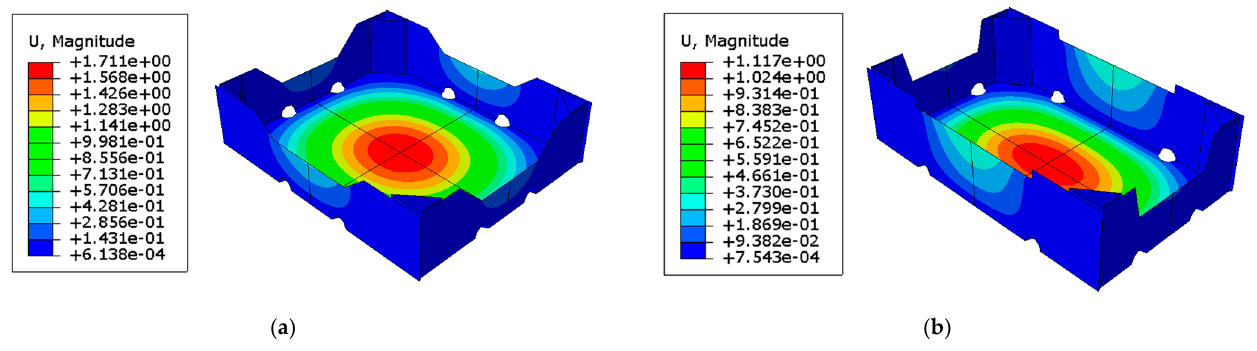
Figure 4. Selected displacement maps after two computational steps: ( a ) case 19 and ( b ) case 20.